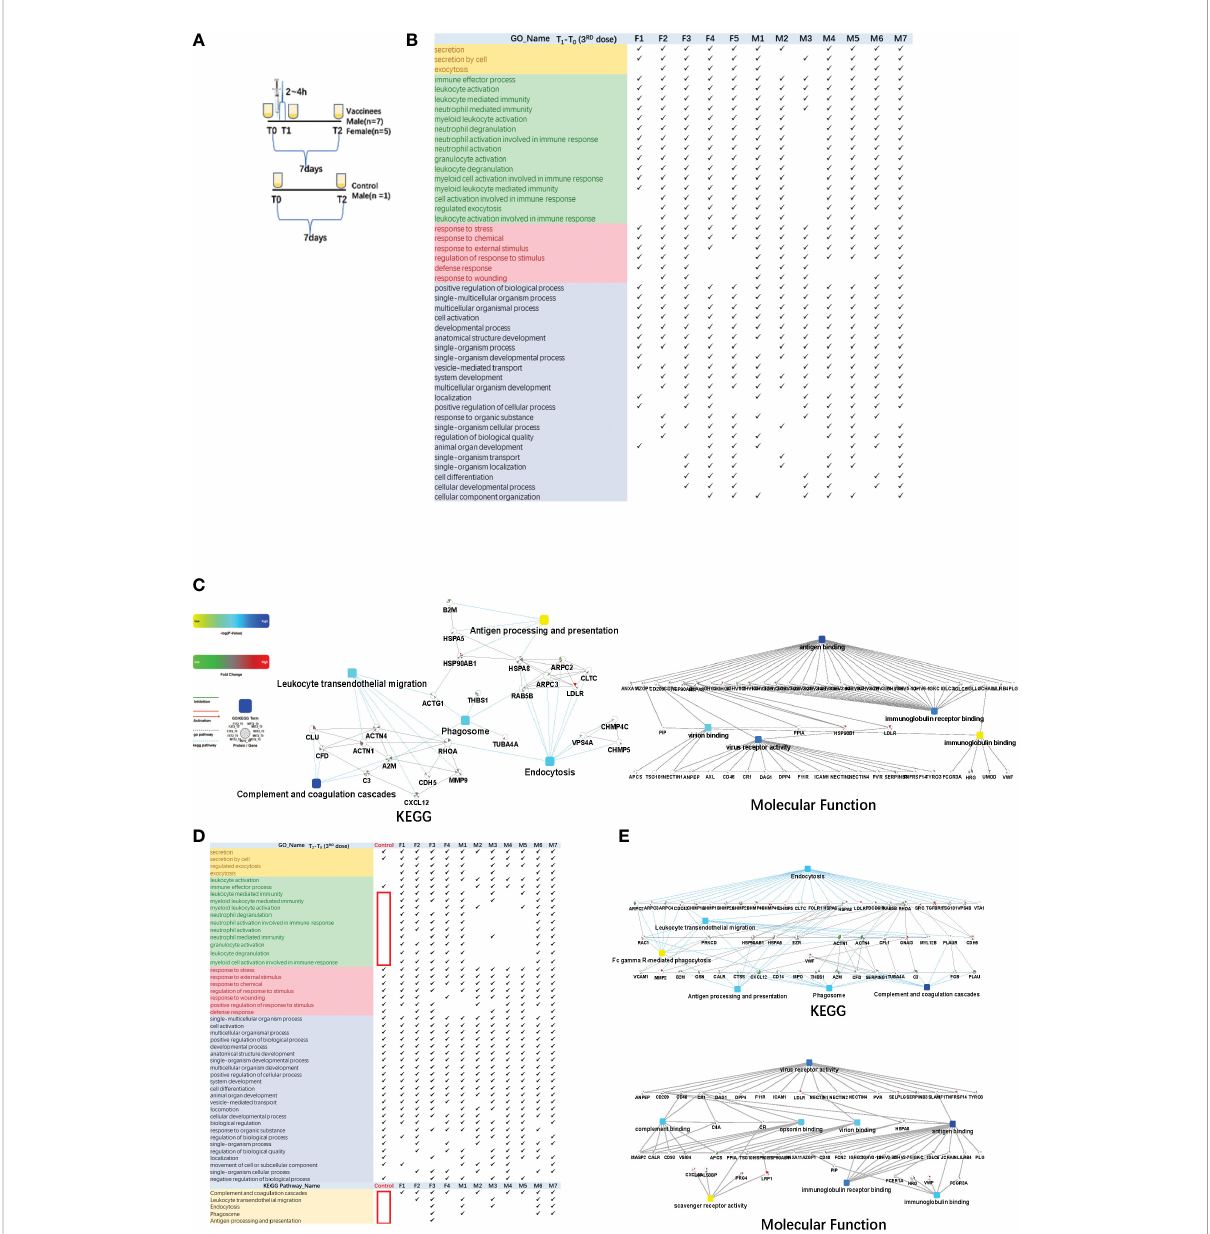
FIGURE 4 Functional analysis of differentially changed proteins in the third dose(booster dose) of COVID-19 vaccinees. (A) Design of the times point of sampling between the vaccinees and the control. All of them had received the fi rst and the second doses of vaccine for more than six months. (B) Demonstration of enriched top 40 immune-related biological processes by differential proteins (fold change > 2 or < 0.5, p-value <0.05) in the comparison between T0 (before the third dose of vaccination) and T1 (2~4h after the vaccination, the fi rst urination after vaccination) of each vaccine, p-value adjusted < e-12. (C) The interaction diagrams showing signi fi cant pathways including KEGG pathway and molecular function (T1-T03rd). The KEGG pathways contains complement and coagulations cascades, endocytosis, phagosome, leukocyte transendothelial migration and antigen processing and presentation (p-value adjusted < 1.1e-2). The enriched molecular function contains antigen binding, virus receptor activity, virion binding, immunoglobulin receptor binding(p-value adjusted < 5.70e-23). (D) Demonstration of enriched top 40 signi fi cant immune-related biological processes and KEGG pathways (p-value adjusted < 0.05)by differential proteins(fold change > 2 or < 0.5, p-value < 0.05) in the comparison between T0(before the third dose of vaccination) and T2 (7days after the vaccination) of each vaccine. (E) The interaction diagrams (T2-T03rd) showing signi fi cant pathways including KEGG pathway(p-value adjusted < 1.18e-3) and molecular function (p-value adjusted < 5.35e-4). (p-value adjusted < 1.18e-3). Network nodes and edges represent proteins and protein – protein associations. Green/red solid lines represent inhibition/activation; gray dotted lines represent GO pathways. Color bar from red to green represents the fold change of protein level from increasing to decreasing. The signi fi cance of the pathways represented by − log (p value) (Fisher ’ s exact test) was shown by color scales with dark blue as most signi fi cant. P-value adjusted was used 'Benjamini-Hochberg' method for multiple